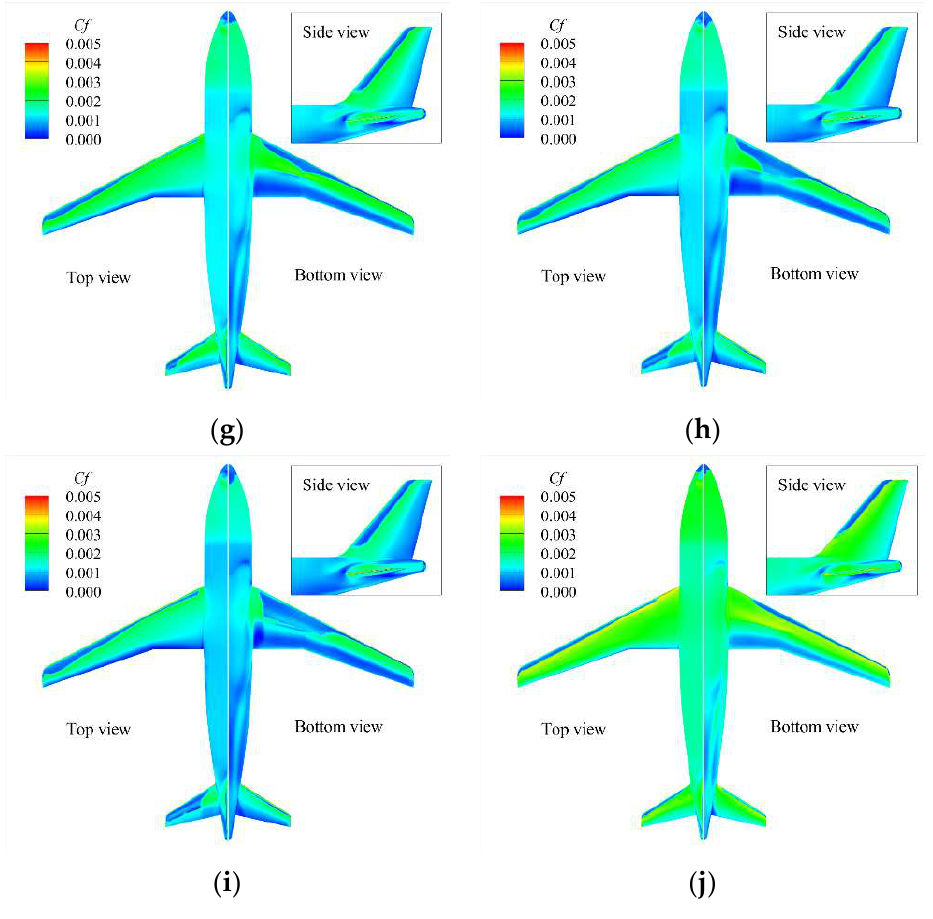
Figure 12. Effect of temperature gradient on skin-friction distribution. ( a ) T w / T inf = 0.49; ( b ) T w / T inf = 0.75; ( c ) T w / T inf = 1; ( d ) T w / T inf = 1.25; ( e ) T w / T inf = 1.51; ( f ) T w / T inf = 2.02; ( g ) T w / T inf = 2.53; ( h ) T w / T inf = 3.04; ( i ) T w / T inf = 3.55; ( j ) adiabatic walls.